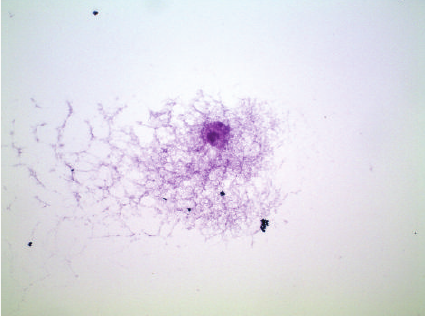
Figure 5: Hematoxylin-eosin. 40x vocal fold: adipose mesenchymal stem cells after isolation, before infusion in animal